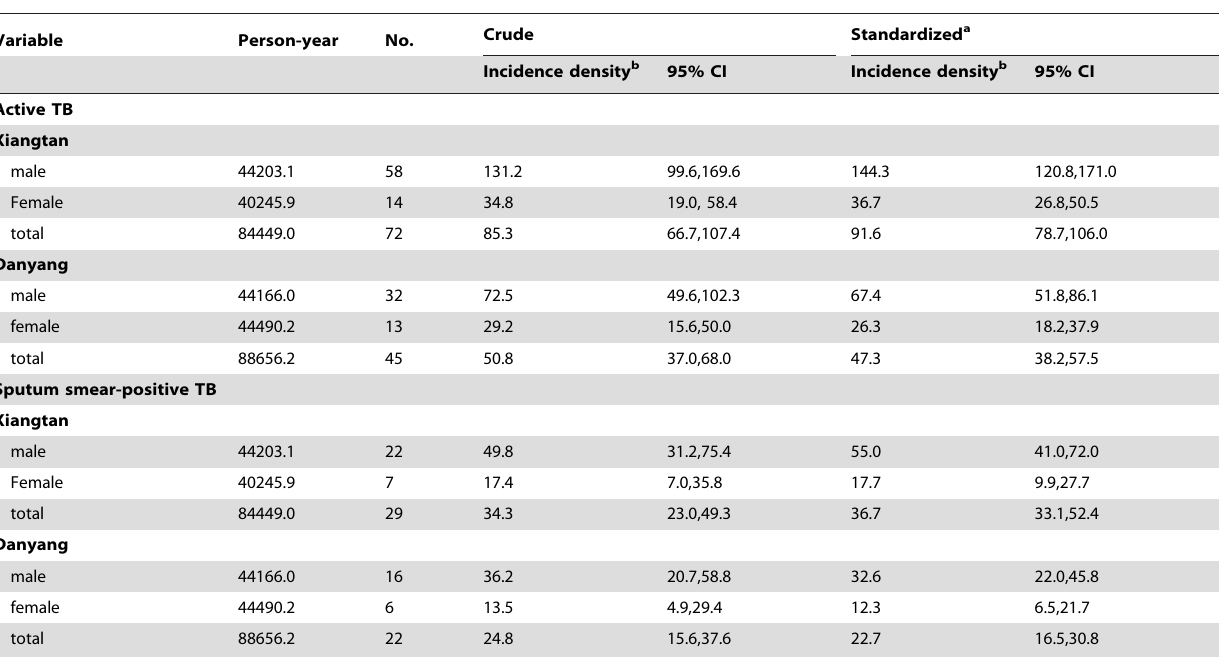
Abbreviation: CI, confidence interval. a Standardized by merged population distribution.